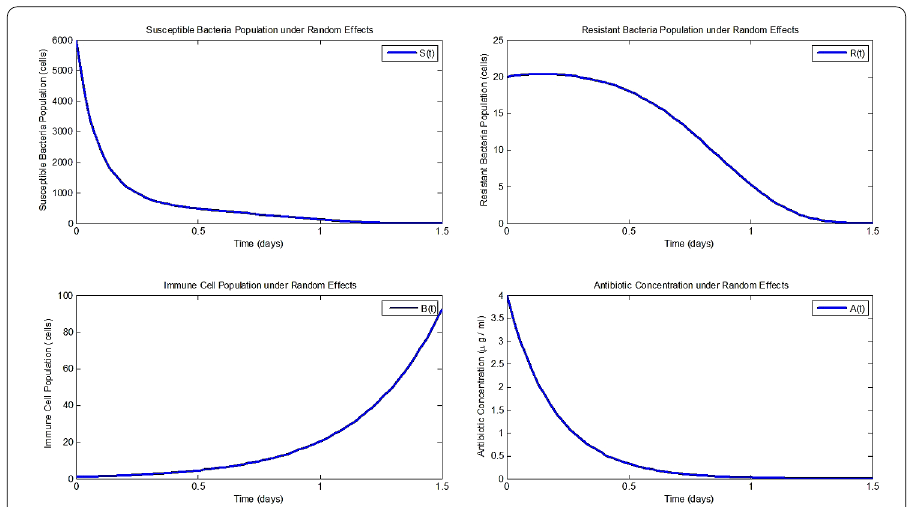
Figure 5 Solution curves of the random model.